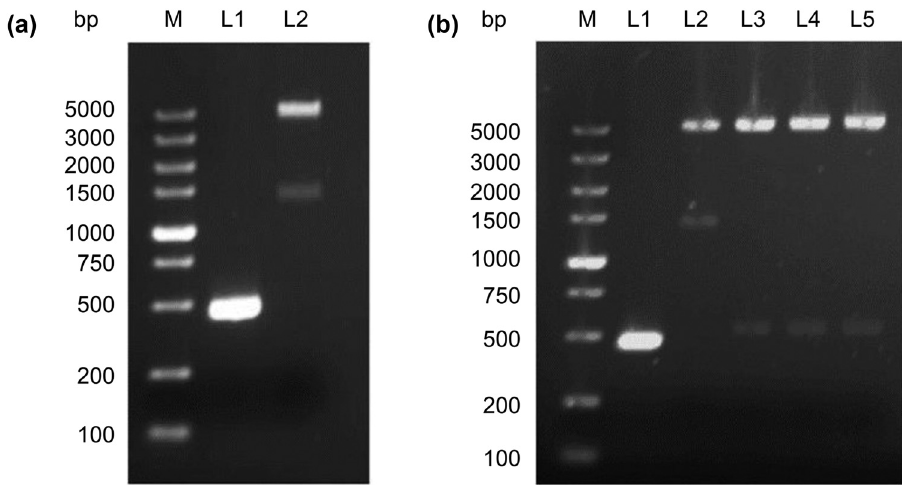
Figure 2: Construction of the pSEL2N1 - hIL2 recombinant plasmid. ( a ) Preparation of the backbone DNA and inserted PCR fragments. M, DL5000 DNA ladder; L1, PCR product of hIL2; L2, pSEL2N1 vector digested with Eco R V and Not I. ( b ) Screening of positive clones by restriction endonuclease digestion. M, DL5000 ladder; L1, PCR product of IL2; L2 ∼ 5, recombinant plasmids identi fi ed by Eco R V and Not I digestion.